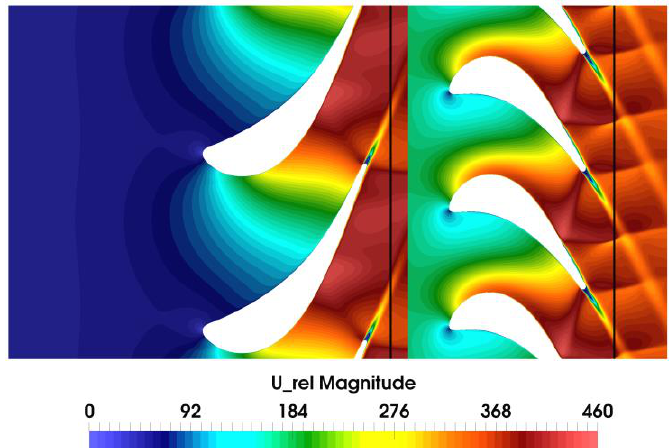
Figure 3. Absolute (stator) and relative velocity (rotor) at mid-span (steady solution).